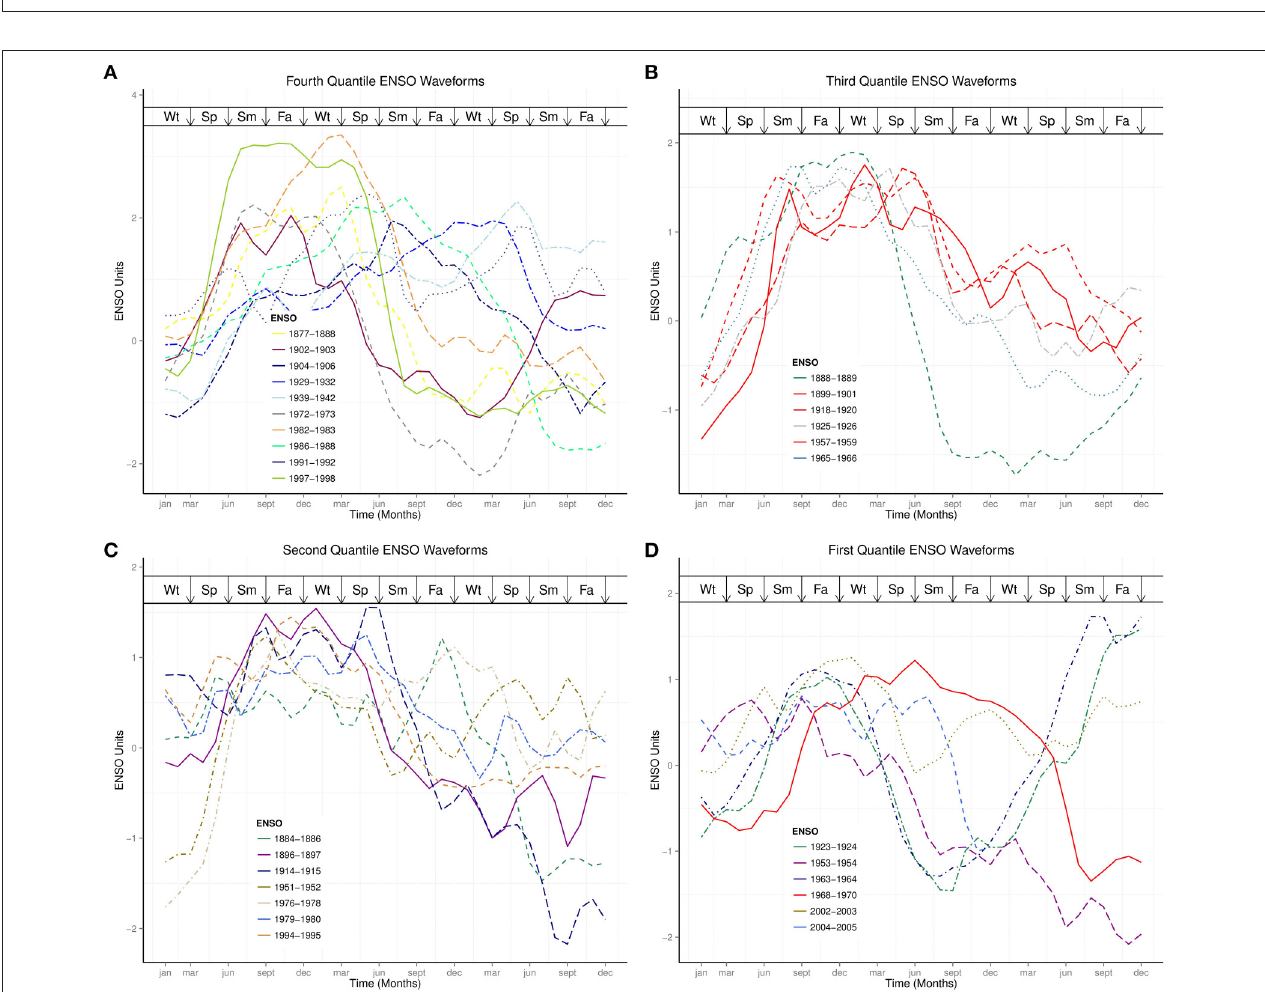
FIGURE 3 | ENSO waveforms of similar strength. (A) Fourth Quantile ENSO Waveforms. (B) Third Quantile ENSO Waveforms. (C) Second Quantile ENSO Waveforms. (D) First Quantile ENSO Waveforms. Wt, Winter; Sp, Spring; Sm, Summer; Fa, Fall.